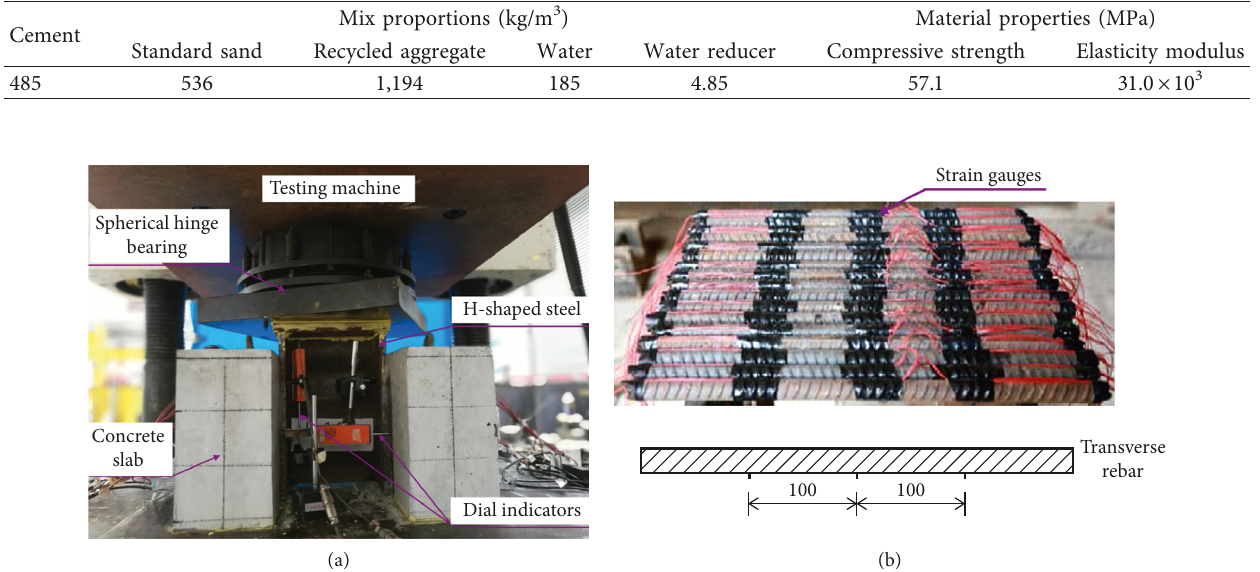
Figure 4: Push-out test apparatus: (a) general layout; (b) strain gauge arrangement (unit: mm).